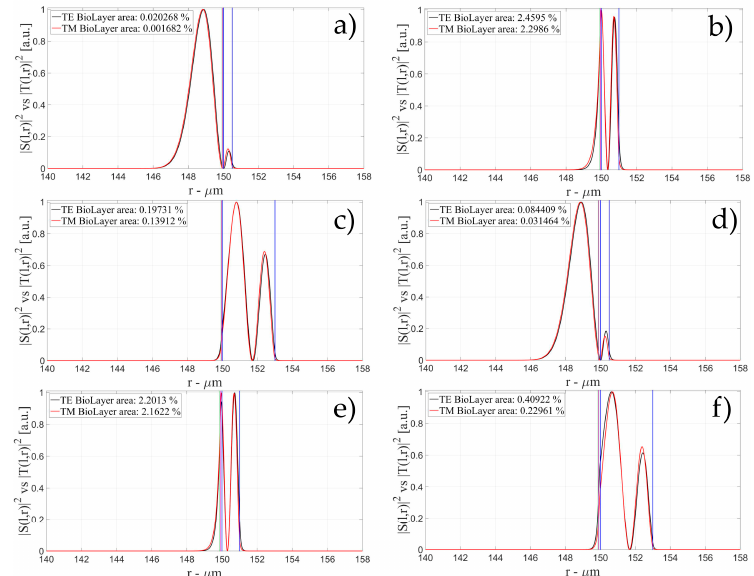
Figure 10. Electric field distribution of WGMs along the radial direction for TE (| S ( l,r ) | 2 ) and TM (| T ( l,r ) | 2 ) modes for the 2nd radial order: ( a ) for a wall of about 500 nm and a polymer thickness of about 50 nm; ( b ) for a wall of about 1 μ m and a polymer thickness of about 50 nm and ( c ) for a wall of about 3 μ m and a polymer thickness of about 50 nm; ( d ) for a wall of about 500 nm and a polymer thickness of about 100 nm; ( e ) for a wall of about 1 μ m and a polymer thickness of about 100 nm and ( f ) for a wall of about 3 μ m and a polymer thickness of about 100 nmLegends show the fraction of | S ( l,r ) | 2 and | T ( l,r ) | 2 inside the biological layer.